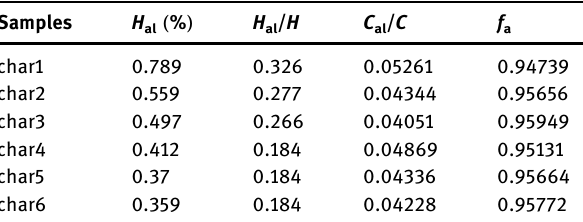
Table 4: Structure parameters deduced from FTIR for chars Samples